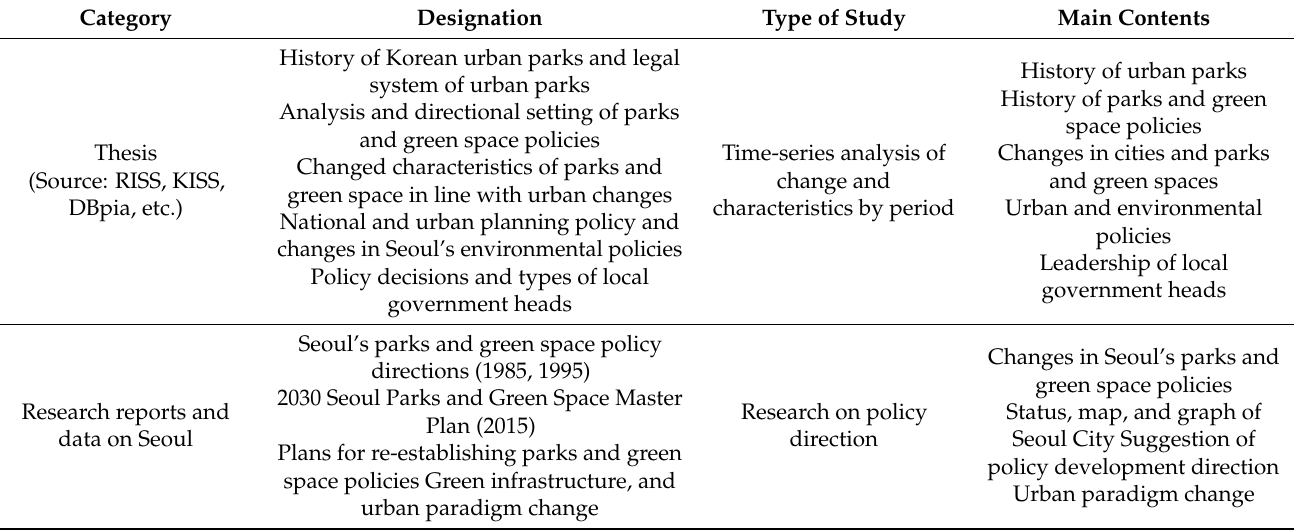
Table 1. Research materials related to city and